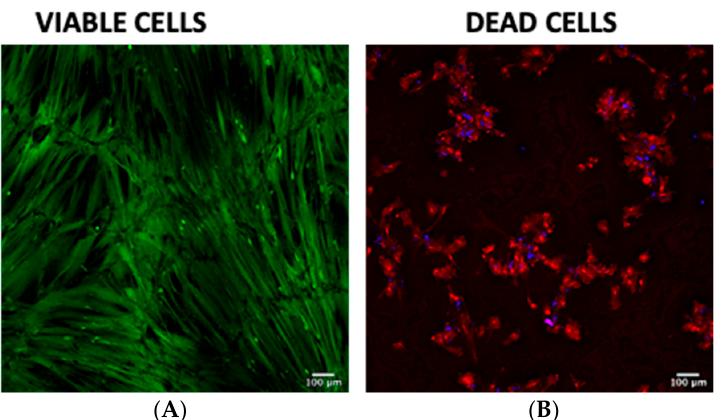
Figure 12. In vitro cell culture and viability of hWJ-MSCs. Confocal microscope microphotographs of hWJ-MSCs at 40× magnification. We seeded 10,000 hWJ-MSCs in monolayer on plain microscope slides. In both, we performed live/dead assay. We observed viable cells (green fluorescence—Calcein—AM) ( A ), and dead cells (red fluorescence—Ethidium homodimer) cell nuclei (blue—DAPI) ( B ).